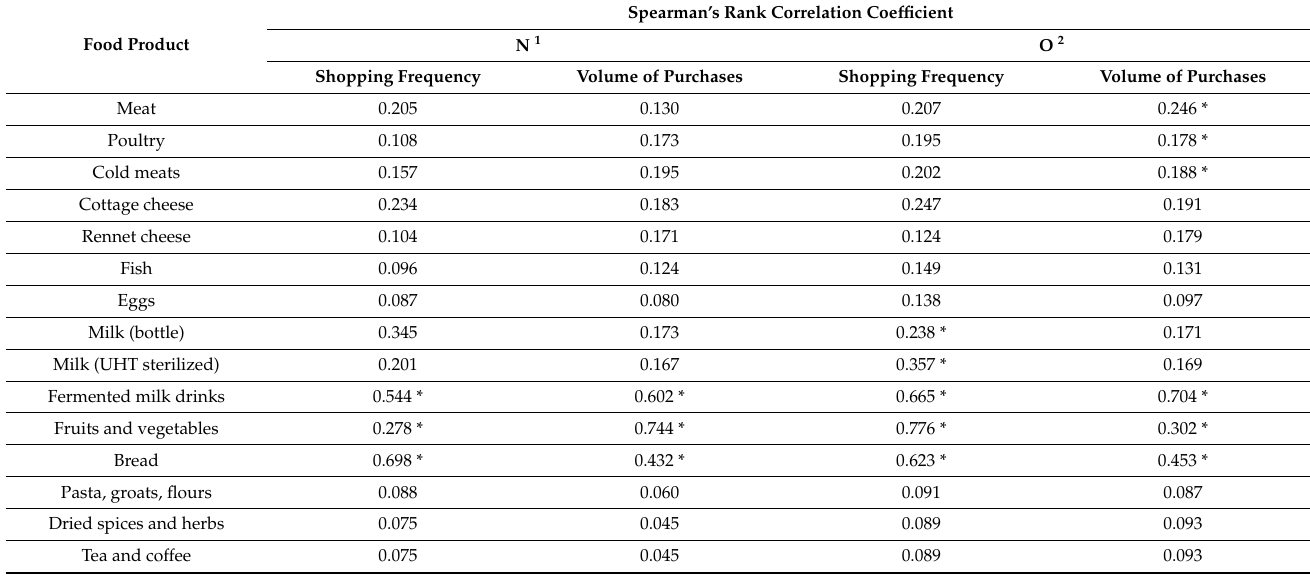
Table 5. Calculated coefficients of the Spearman rank between the shopping frequency and volume of purchases and the frequency of throwing away food